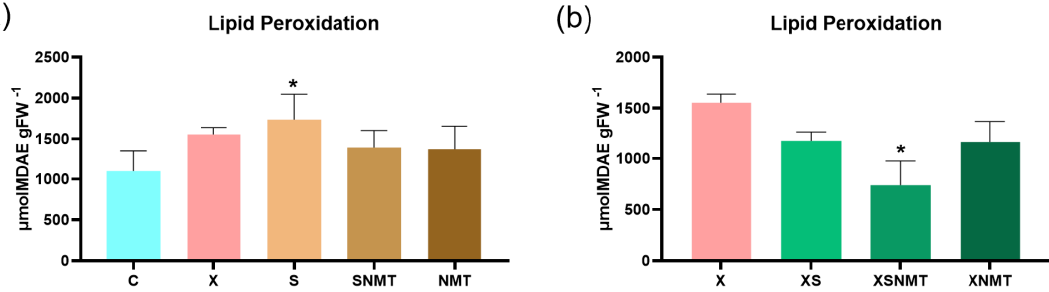
Figure 3. MDA content of S. lycopersicum shoots 3 days after Xeu inoculation, and 24 h after the application of treatments; ( a ) represents the uninfected/treated conditions (S; SNMT; NMT) and the infected/untreated control (X) compared to the uninfected/untreated control (C); ( b ) represents the infected/treated conditions compared to the positive control (X). Values are presented as mean ± SD ( n = 3). Means marked with “*” are statistically different from the respective control, according to the Dunnett comparison test ( p < 0.05). C: uninfected untreated shoots (negative control); X: infected untreated shoots (positive control); S: uninfected shoots treated with S. montana EO; SNMT: uninfected shoots treated with S. montana EO + NMT formulation; NMT: uninfected shoots treated with NMT; XS: infected shoots treated with S. montana EO; XSNMT: infected shoots treated with S. montana EO + NMT formulation; XNMT: infected shoots treated with